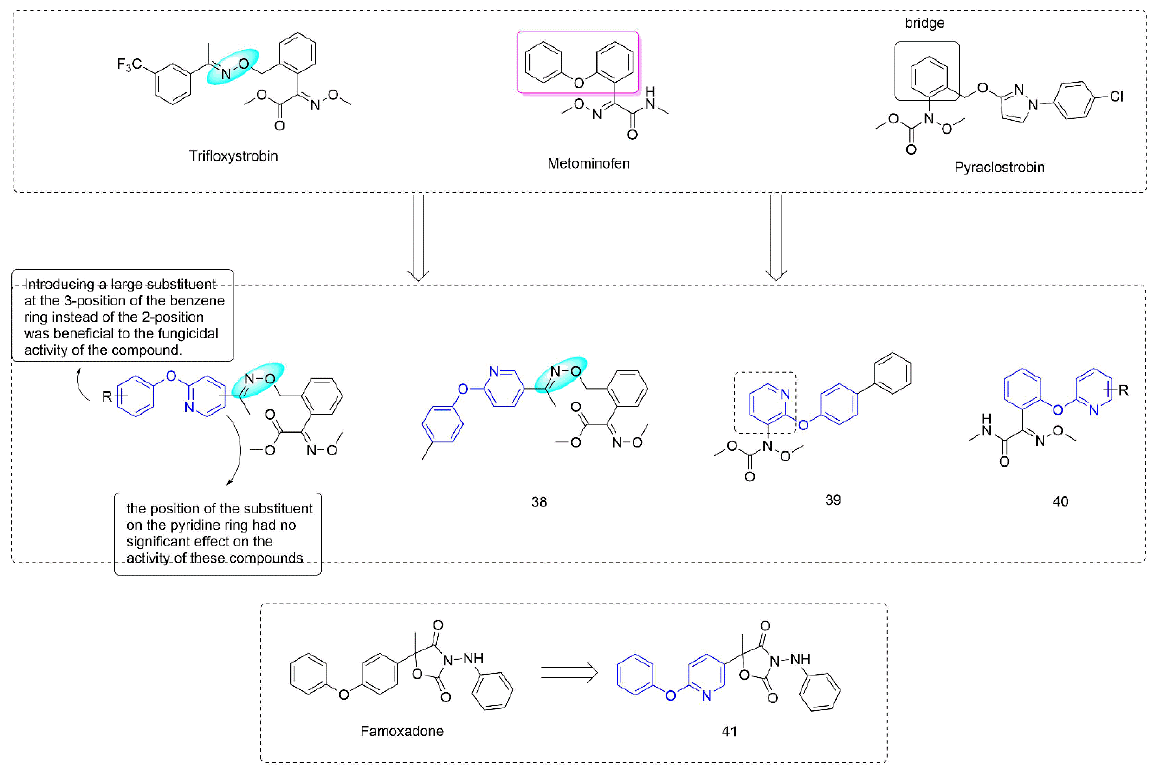
Figure 7. Complex III inhibitors containing phenoxypyridine.